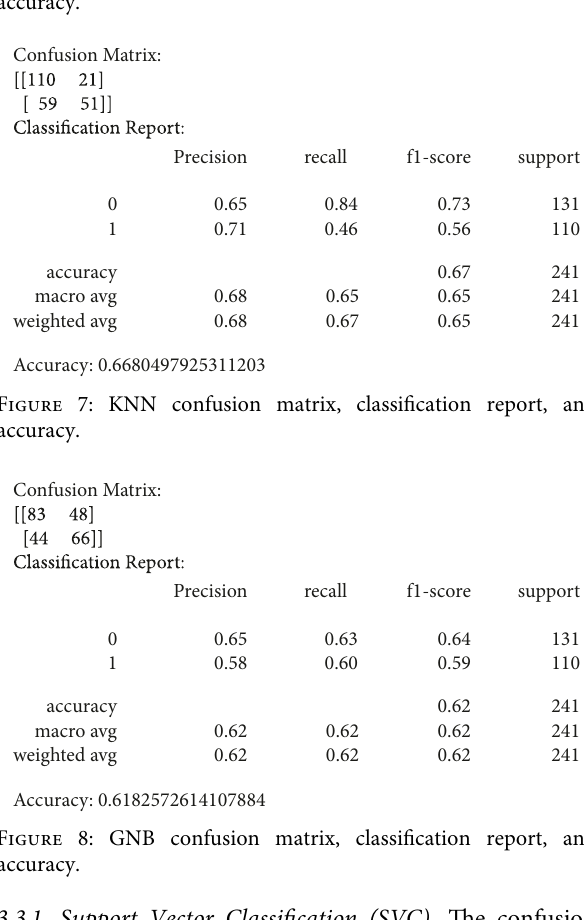
Figure 6: SVC confusion matrix, classification report, and accuracy.